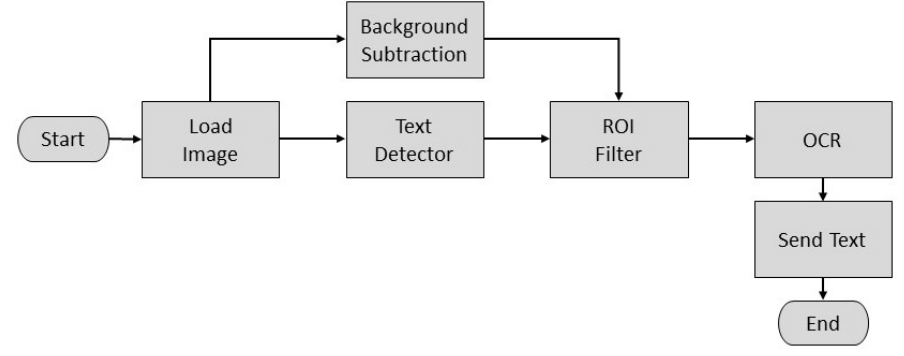
Figure 5. Conversion from image to text.